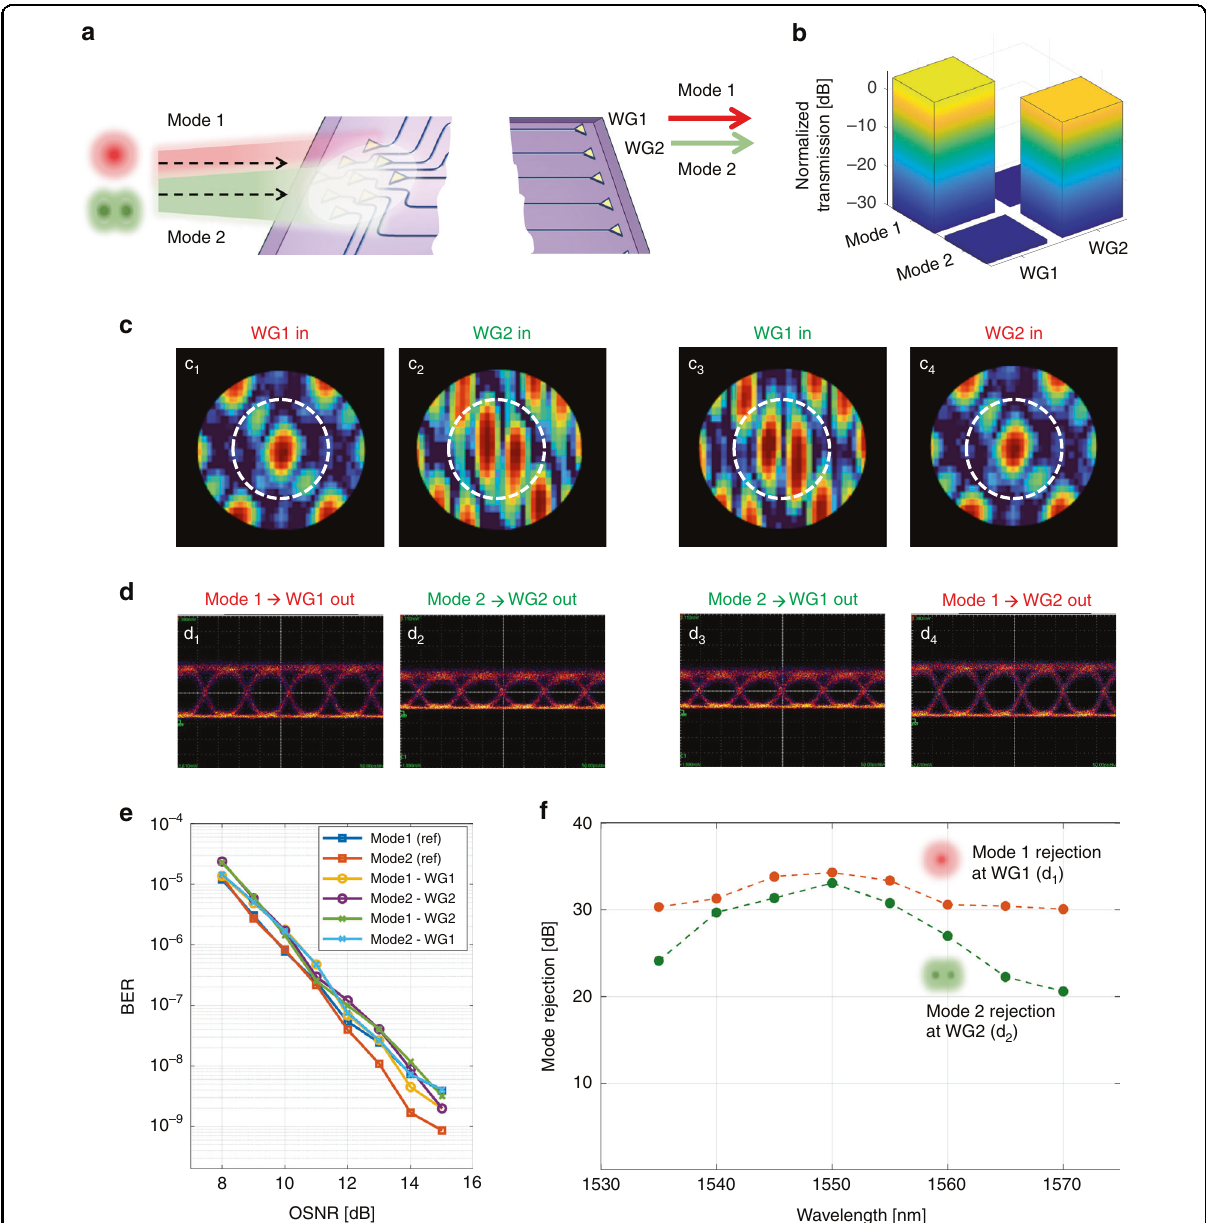
Fig. 3 Mode-diversity receiver. a Schematic representation of two free-space modes (Mode 1 and Mode 2), sharing the same wavelength and state of polarization, and arriving at the receiver from the same direction. b Bar chart showing the normalized received power of the Mode 1 and Mode 2 at the output waveguides WG1 and WG2. c Backward far- fi eld intensity pattern radiated by the 2D optical antenna array when the photonic processor is con fi gured to couple Mode 1 to WG1 (c 1 ), Mode 2 to WG2 (c 2 ), Mode 2 to WG1 (c 3 ) and Mode 1 to WG2 (c 4 ) entering from WG1 and WG2. Circles indicate the position of the zero-order diffraction. d Measured eye diagrams of two intensity modulated 10 Gbit/s OOK signals transmitted by using Mode 1 and Mode 2 for the con fi gurations considered in ( c ). e BER measurements of 10 Gbit/s OOK channels simultaneously transmitted in free space on spatially overlapped modes (Mode 1 and Mode 2) and separated by the photonic processor. Blue and red squares indicate the reference BER measured when only one data channel is switched on. Negligible OSNR penalty is observed for any data channels sorted out by the photonic processor. f Wavelength dependence of the mutual mode rejection at the output ports of the photonic